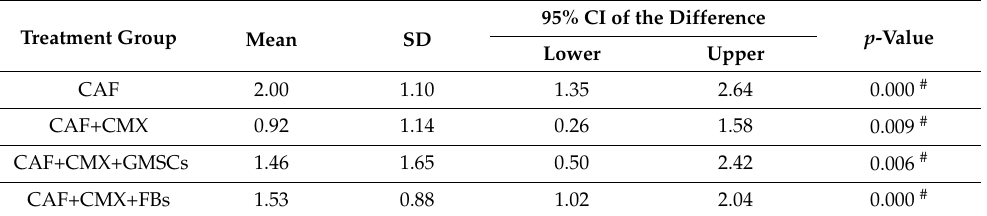
Table A1. Total Gingival Recession Reduction from Baseline to the End of the Follow